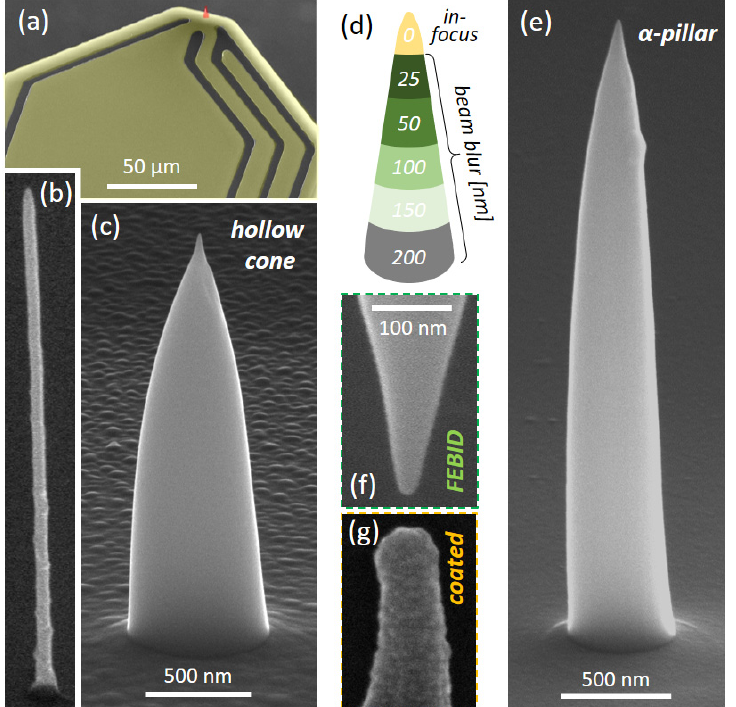
Figure 1. Design aspects of FEBID-based Co 3 Fe MFM tips. ( a ) tip-less SS-CL with a flexible electrode system (yellow) to adapt to different AFM probe concepts (Nice CL, GETec Microscopy) [39], revealing a nano-tip at the very end (red). While ( b ) shows a single pillar, produced by a static e-beam (5 keV, 5.2 pA, same scale bar as in ( e )), ( c ) gives a 3D-nano printed Co 3 Fe hollow cone (20 keV, 53 pA, 1250